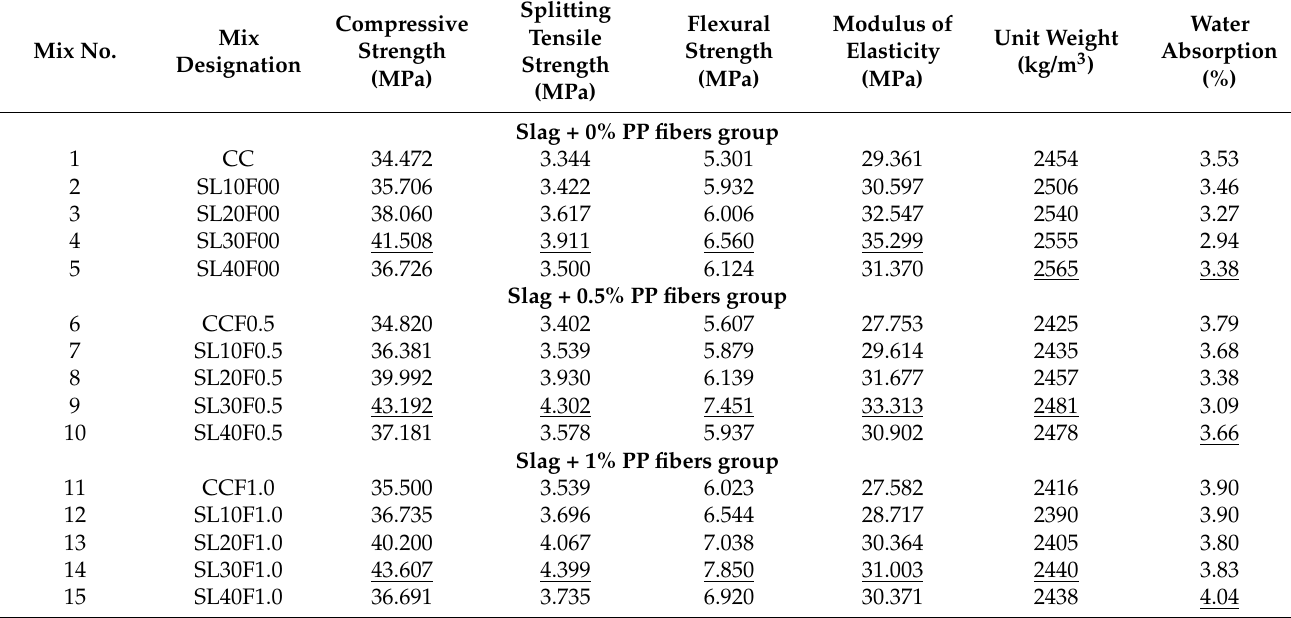
Table 7. Summary of experimental results of all concrete